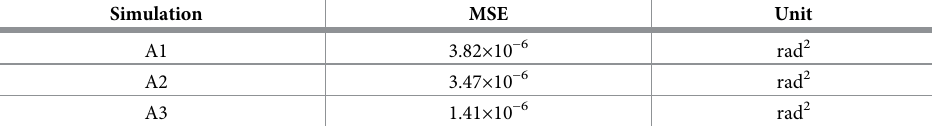
Fig 3. The results of the validation experiment A2: The mean net phase versus the duration of the gradient pulse δ for anisotropic diffusion ( D ? / D k = 0.5). https://doi.org/10.1371/journal.pone.0281332.g003 Table 2. The MSE of the net phase between the simulation and the analytic model for the validation